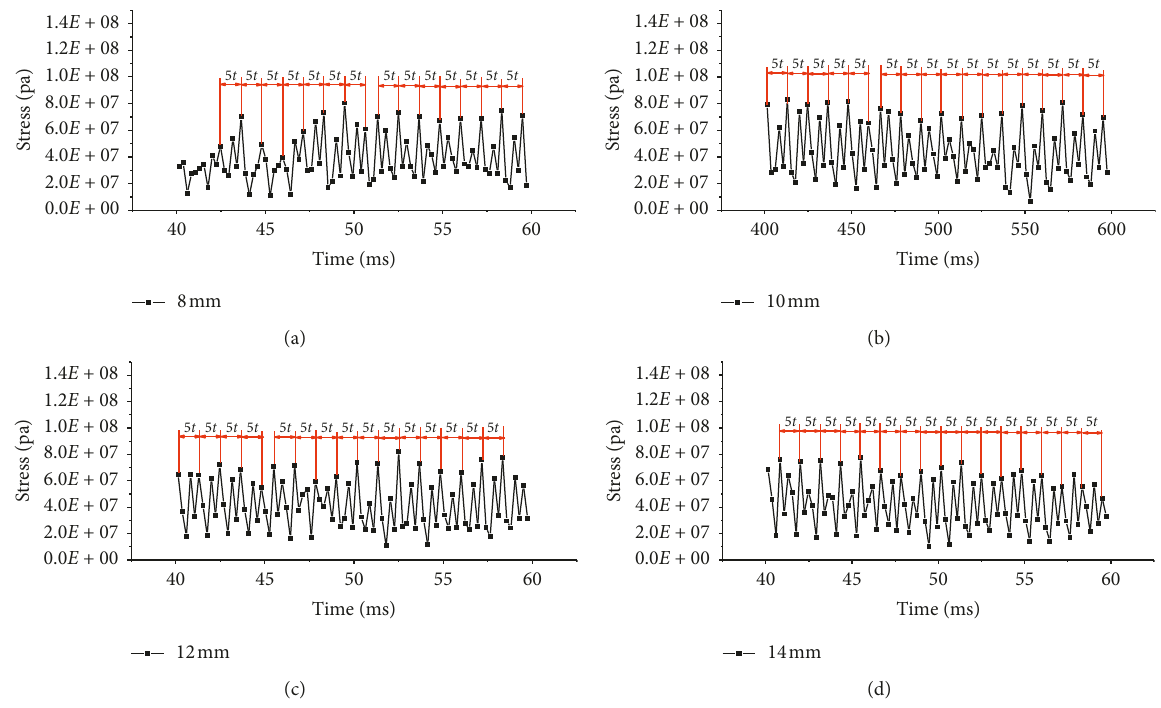
Figure 10: Stress fluctuation cycle period at different cutting depths ( α � 10 ° and V � 1.36m/s): (a) h � 8mm; (b) h � 10mm; (c) h � 12mm; (d) h �